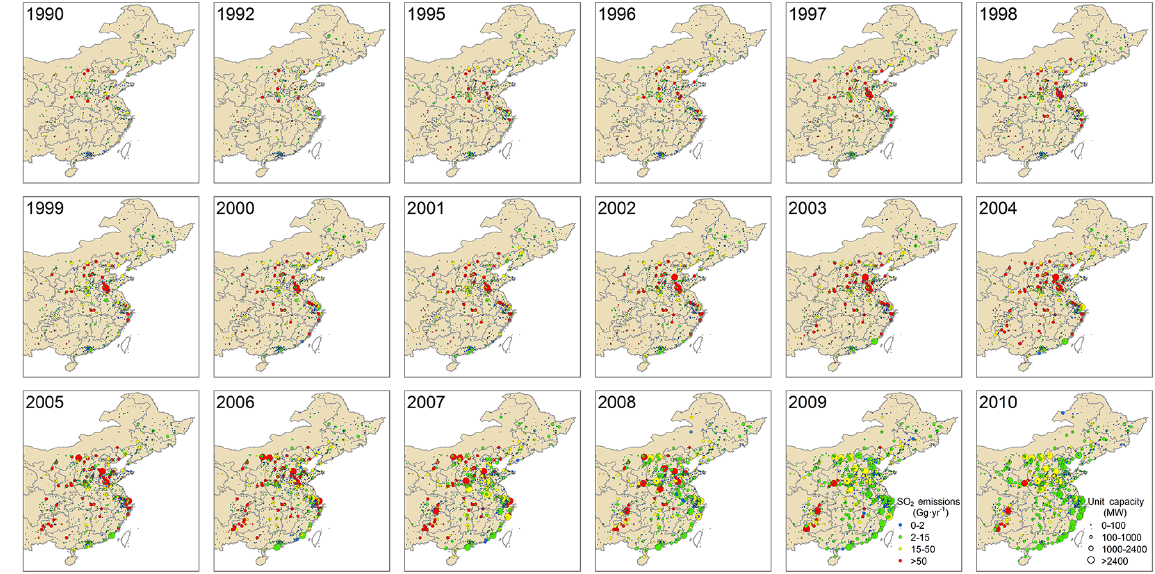
Figure 9. Evolution of SO 2 emissions from coal-fired power plants in China, 1990–2010. Units: Ggyr − 1 .